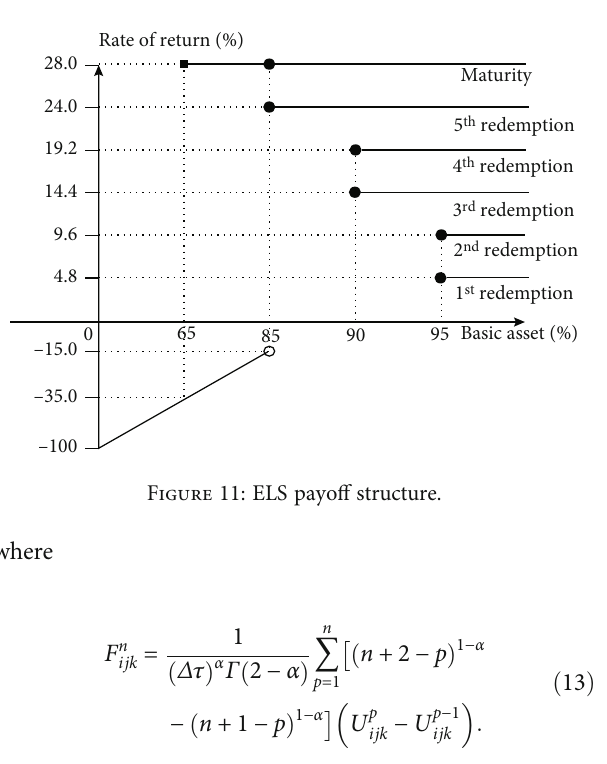
Figure 10: Nonuniform mesh in a comparison test.